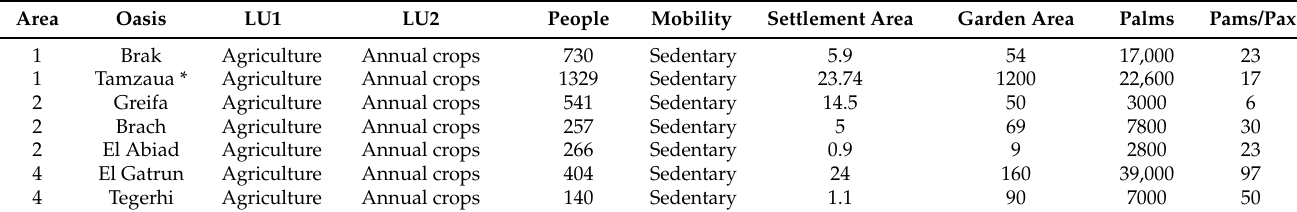
Table 2. Demographic, land use and crop data for selected oases in the Fazzan in the 1930s [35–37]. For the location of the oases, see Figure 4. LU1 = Land Use level 1; LU2 = Land Use level 2; areas are expressed in ha; garden area